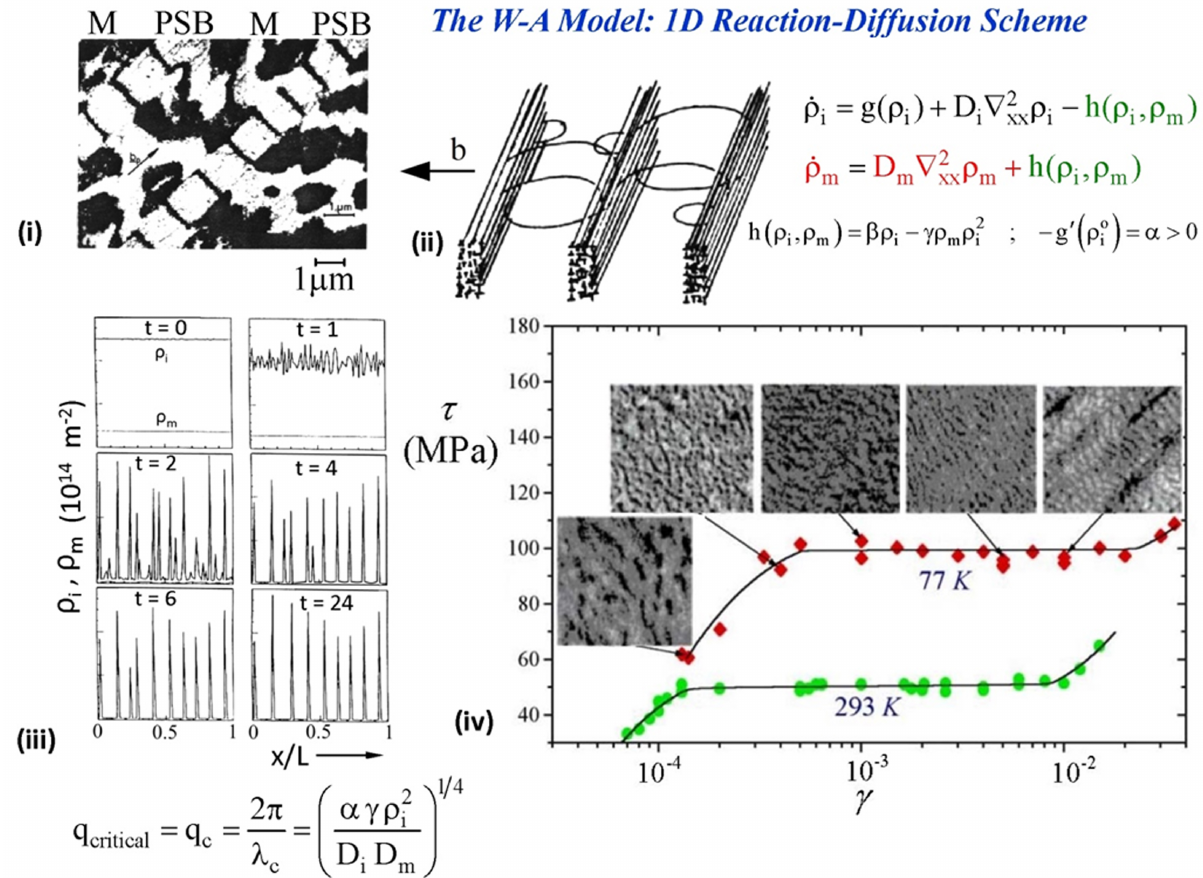
Figure 1: (i) Persistent slip band (PSB) and dislocation multipole matrix (M) formation in fatigued Cu crytstals; (ii) The corresponding system of R-D type equations for immobile and mobile dislocations (W-A model); (iii) Solutions of the W-A equations describing the periodic structure of PSBs; (iv) The evolution of stress ( τ ) – strain ( 𝛾 ) curve showing the constancy of stress during PSB formation. For related details the reader can consult [1, 3, 11b] and references quoted